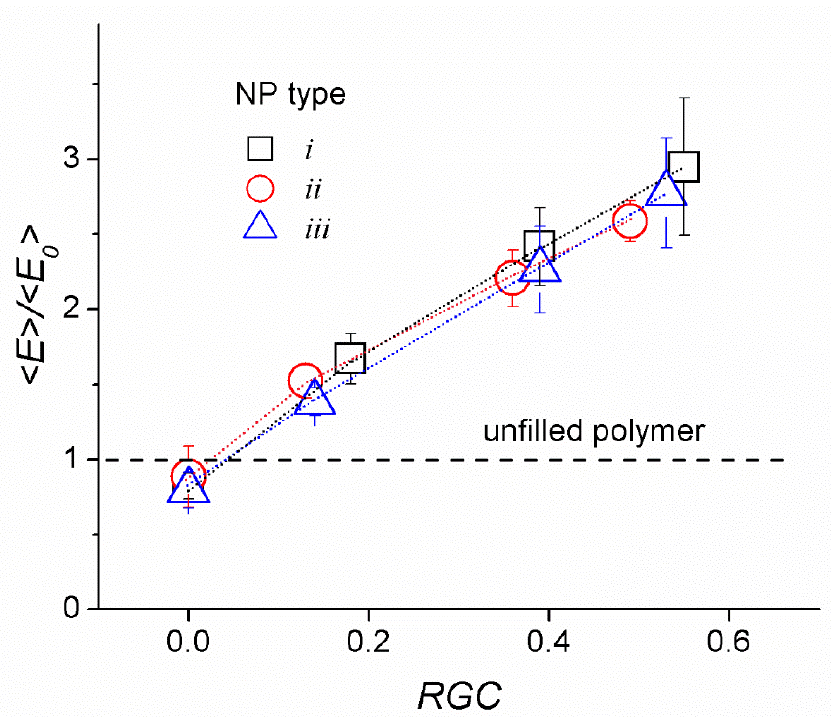
Figure 7. Normalized averaged Young’s modulus < E >/< E 0 > ( α = x , y , z ) for the nanocomposite nanoparticles of i , ii, and iii types. Here < E > is average E α at different cross-linked degrees of NPs with matrices. We use the average value for the elastic moduli E α of the unfilled polymer as a reference value < E 0 > = 8.04 ± 0.27 DPD units. The dashed line corresponds to the unfilled